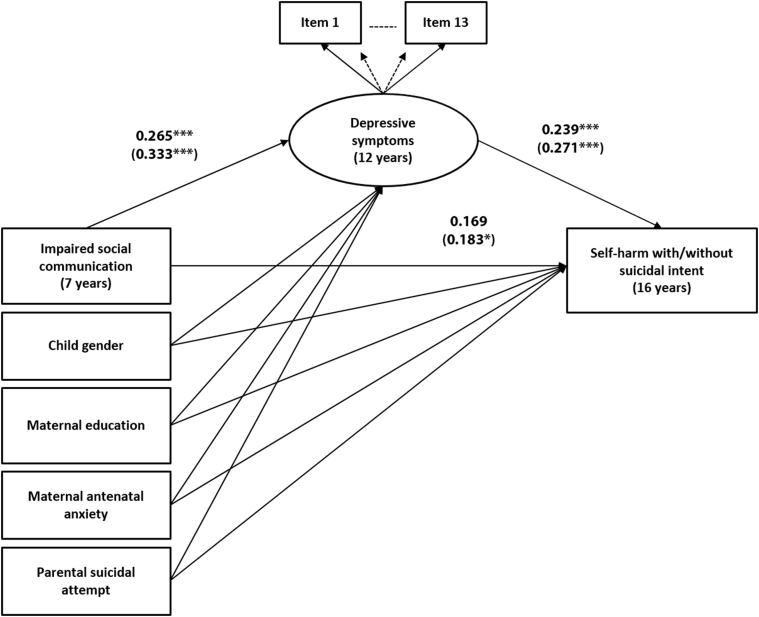
Structural Mediation Model Estimating the Direct Effect of Impaired Social Cognition on Lifetime Self-Harm at 16 Years and the Indirect Effect Through Child’s Depressive Symptoms at 12 Years (Adjusted for Potential Child, Maternal, and Socioeconomic Confounders)Note:Path estimates on the edges are adjusted unstandardized regression coefficients (β). Observed variables are represented by squares, whereas the latent variable is represented by a circle. Covariances are not shown to reduce figure complexity. Paths coefficients in brackets are from the imputed data analysis. *p ≤ .05; ***p < .001.